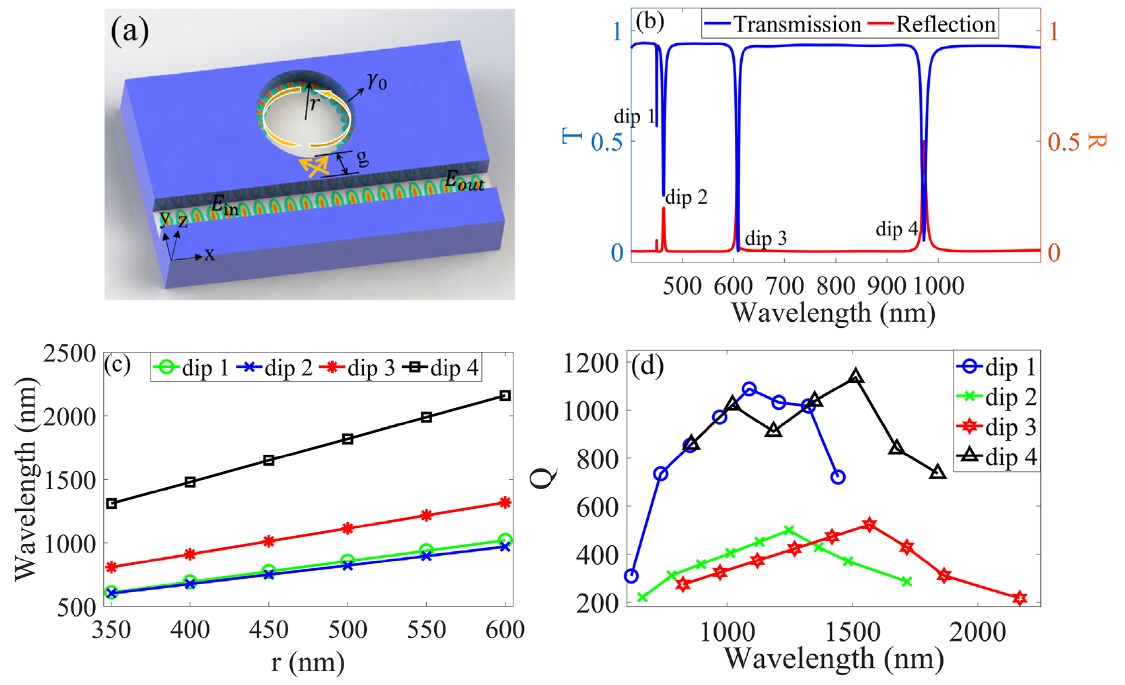
Figure 1. Transmission properties of the cavity–waveguide system. ( a ) Structural schematic. ( b ) The transmission and reflection spectra. ( c ) Influence of radius ( r ) on transmission. ( d ) Q variations in four dips.